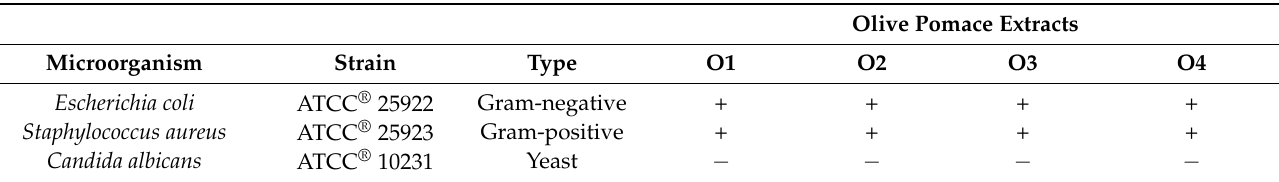
Table 3. General results of the antimicrobial activity of the olive pomace extracts.